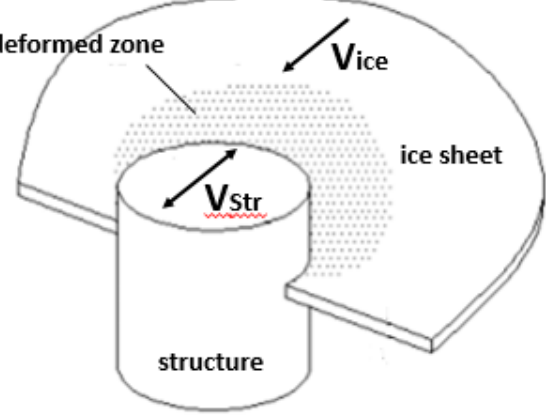
Figure 14. Outline of the ice sheet crushing the cylindrical structure.